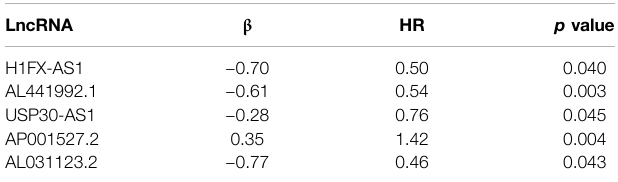
TABLE 3 | The optimal immune-related prognostic LncRNAs screened out by multivariatecoxregressionanalysisandtheAICvalue, fi velncRNAswereused to construct the prognostic